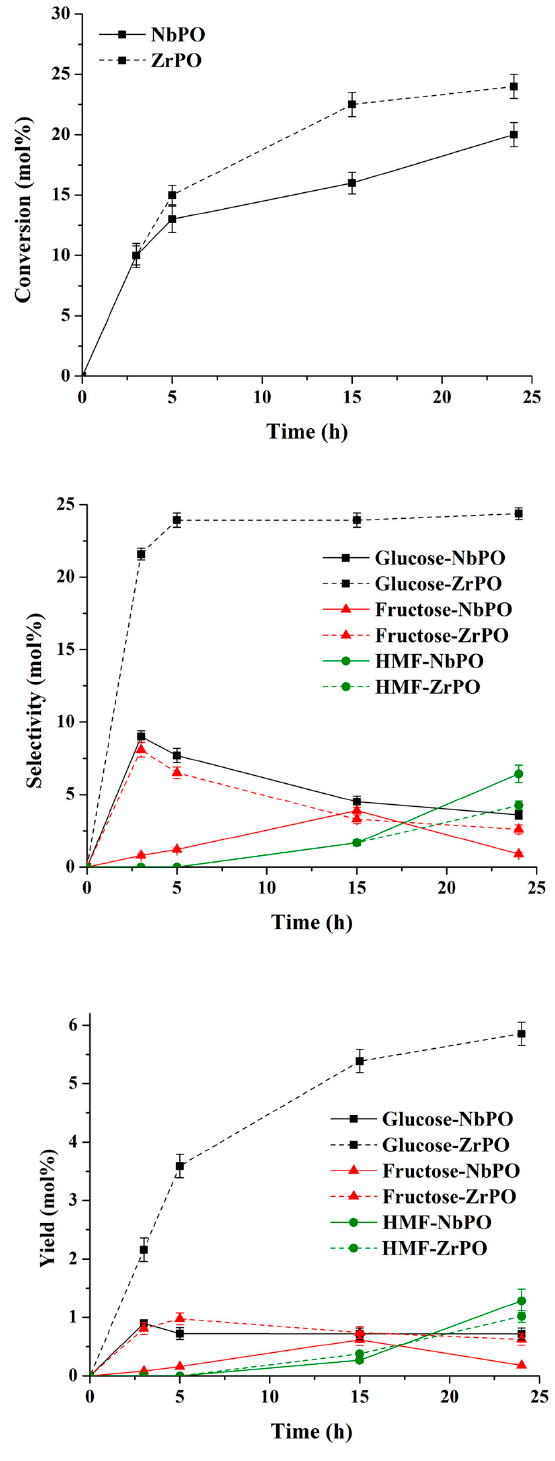
Figure 8. Catalytic performances of NbPO and ZrPO in the conversion of untreated cellulose at 150 °C. Reaction conditions: cellulose = 2.63 g, catalysts = 2.20 g, water = 50.0 g, T = 150 °C, autogenic pressure (LA is present only in traces). Note: where the error bars are not visible, they are smaller than the symbols.